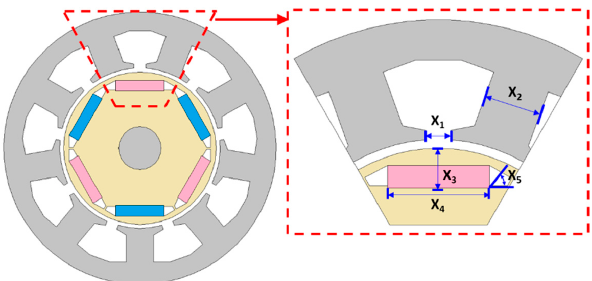
Figure 6. Cross-section of the BLDC motor and design variables. where X 1 is the length of slot